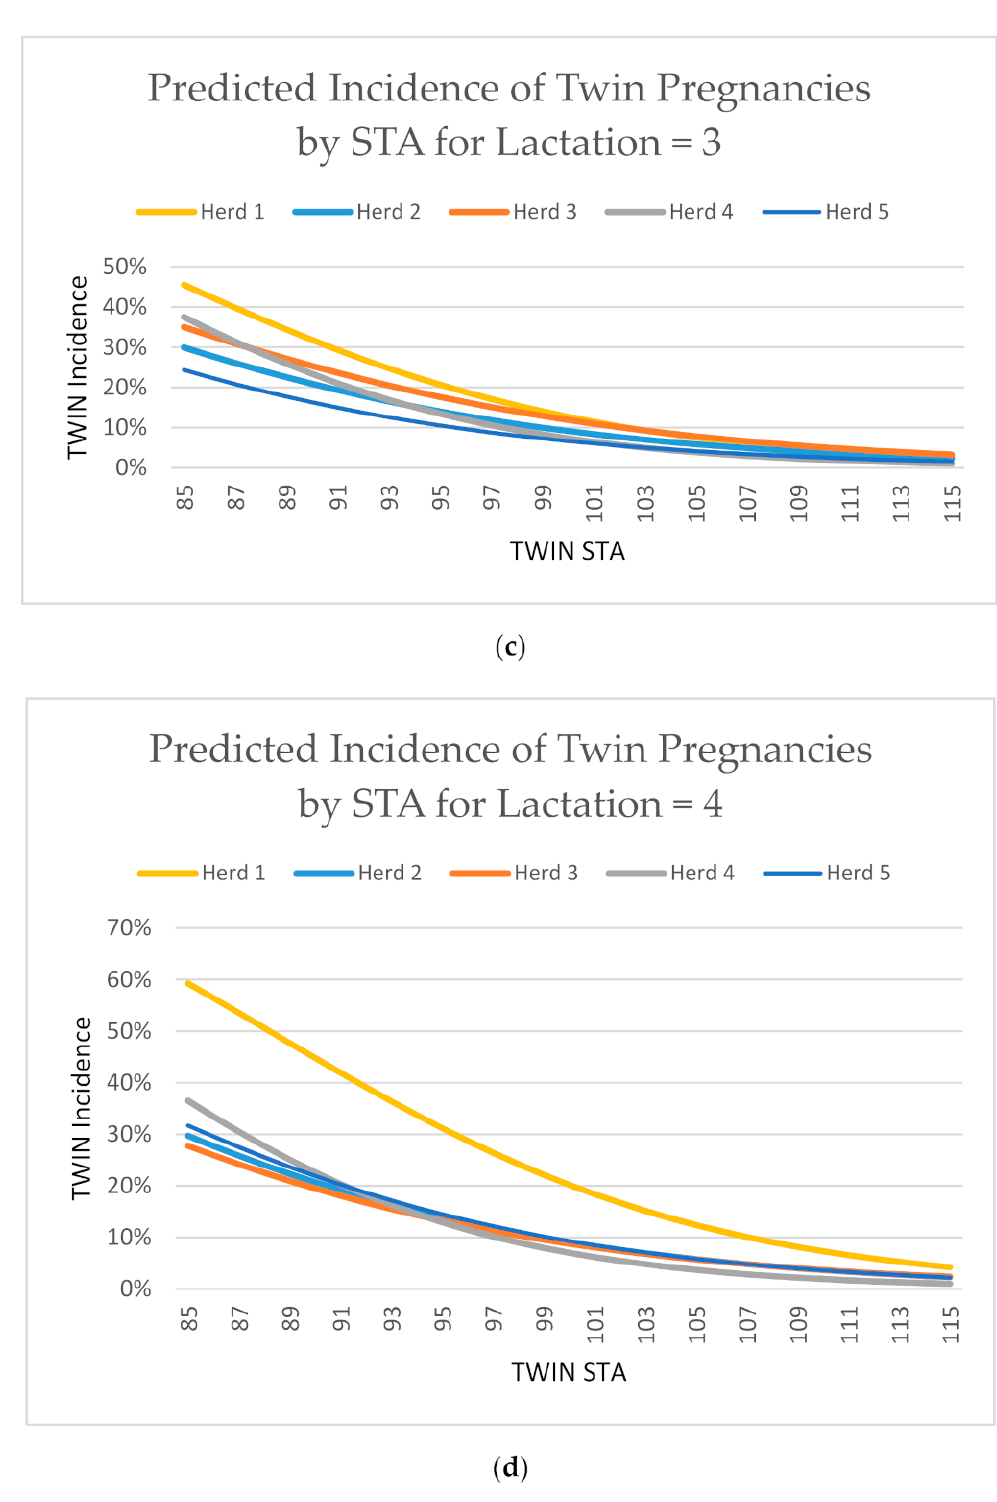
Figure 2. ( a – d ) illustrates the association between TWIN incidence and individual females ranked by TWIN STAs on a per lactation basis (1st–4th), for each herd. As expected, as the TWIN STA increases (i.e., the expected risk of a Holstein female of being pregnant with twins in a given lactation decreases), so too does the TWIN incidence, across all herds, all reproduction protocols, and across all